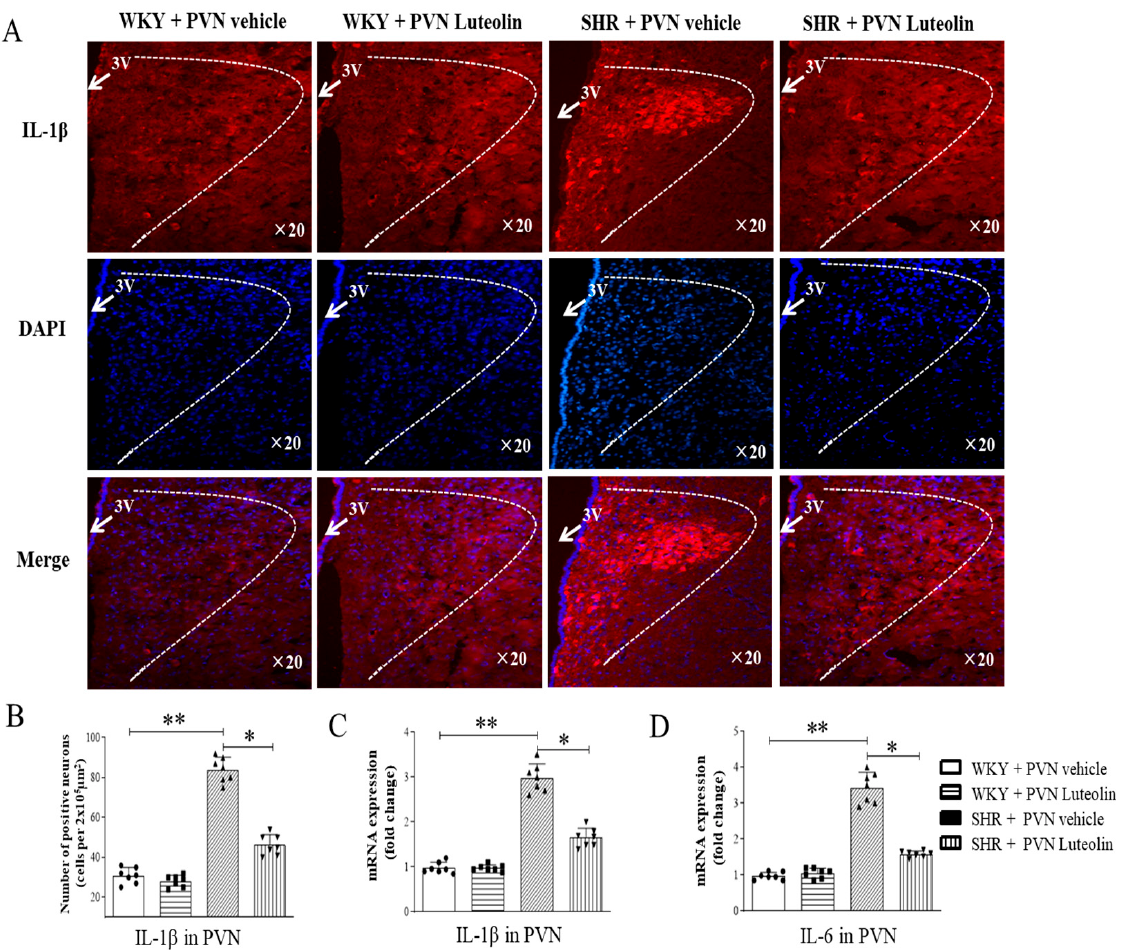
Figure 4. Effects of PVN luteolin on inflammatory cytokine in PVN. ( A ) A representative immunomicrographs presenting IL-1 β positive cell (red fluorescence). ( B ) Quantification of the number of IL-1 β positive cells in PVN of SHRs and WKY rats, with or without luteolin treatment. ( C ) Determination of the expression level of mRNA of IL-1 β and IL-6 ( D ) changes in PVN of SHRs and WKY rats treated with luteolin or aCSF. Values are the mean ± SEM from 7 rats/group. * p < 0.05, ** p < 0.01. 3V, third ventricle.